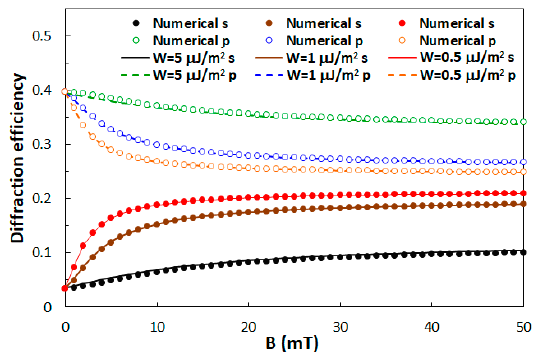
Figure 8. The diffraction efficiency of the 1st diffraction order for s- and for p-polarized incident beam as a function of the applied external magnetic field calculated for three different anchoring strengths.